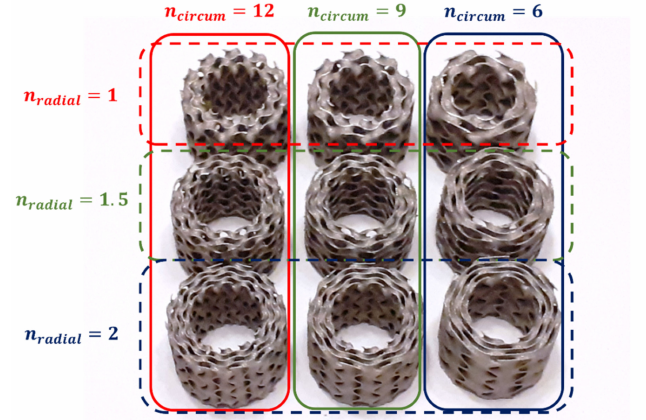
Figure 6. Cylindrical mapped TPMS structures with shell gyroid unit cells fabricated by selective laser melting (SLM) with 316L stainless steel used in the